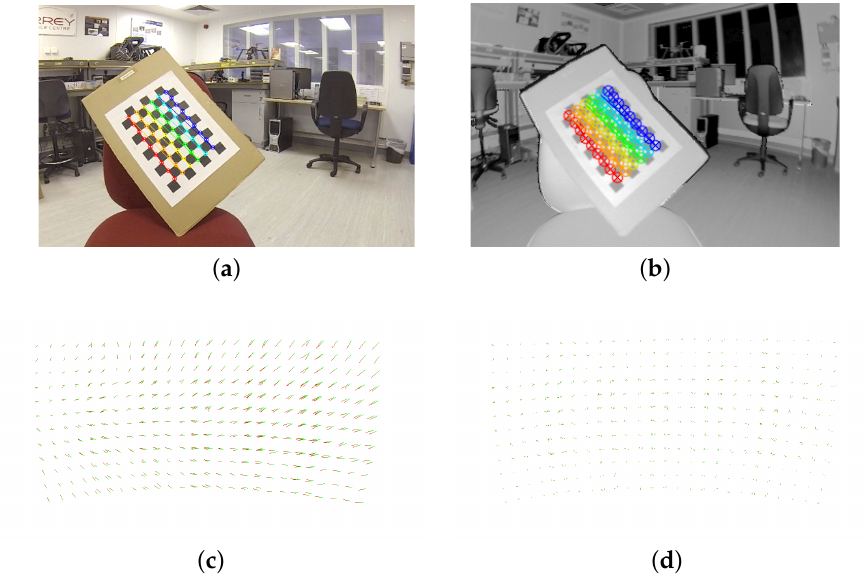
Figure 11. Extrinsic and intrinsic calibration of the sensor suite, ( a , b ) illustrate the camera and LIDAR views respectively; ( c , d ) illustrate the target points before and after calibration